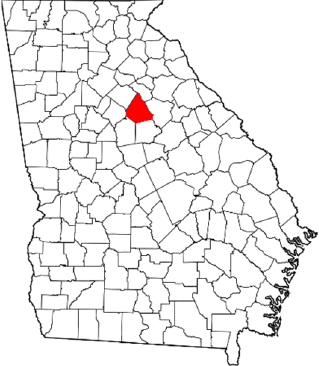
Figure 2. This map shows Morgan County’s location adjacent to Walton County in northeastern Georgia. (“Location of Morgan Co., GA, within the U.S. State of Georgia”, by David Benbennick, Publick Domain (https://en.wikipedia.org/wiki/Morgan_County,_Georgia#/me- dia/File:Map_of_Georgia_highlighting_Morgan_County.svg, accessed on 7 August 2022).